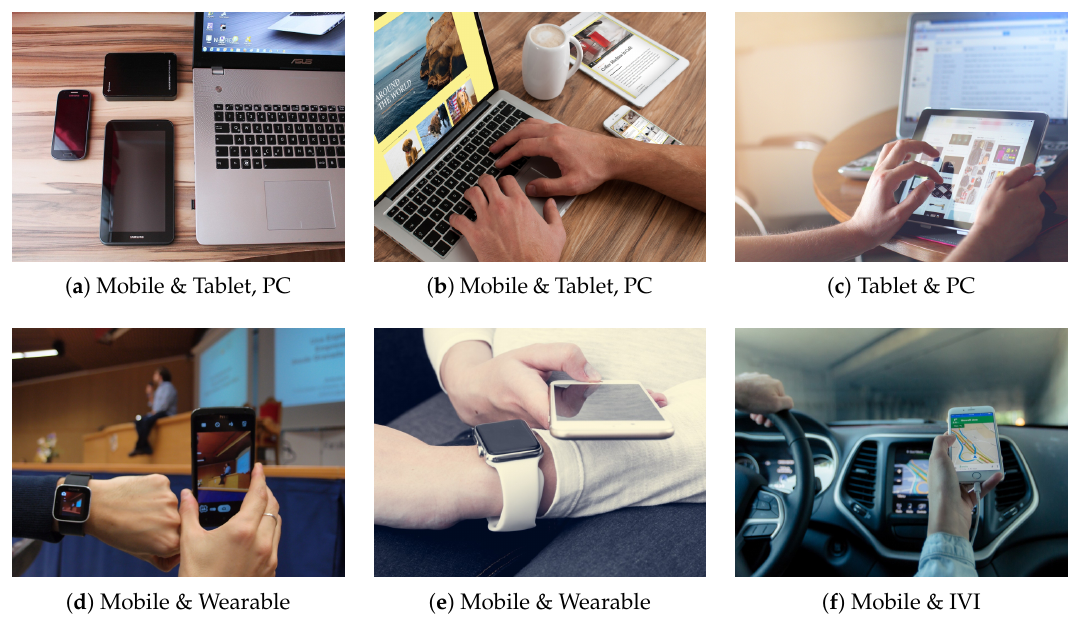
Figure 1. MCI examples with mobile, tablet, PC, wearables and